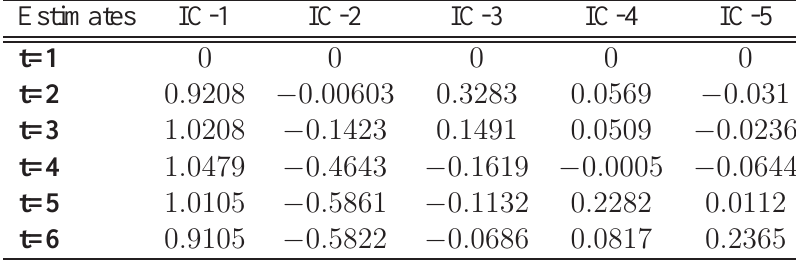
Table 3: Estimated Mixing Matrix with 5 IC.